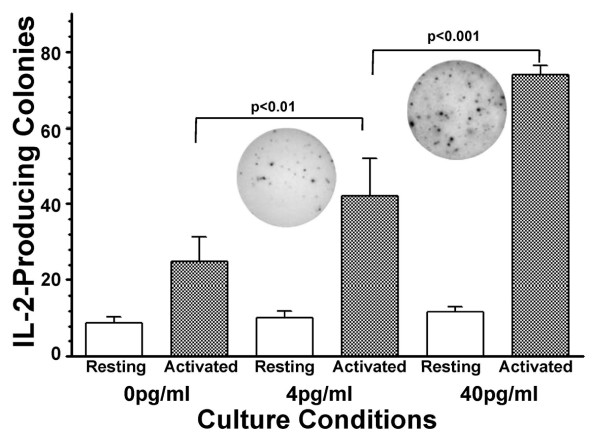
Interleukin-2 (IL-2) production following induction by PMA and ionomycin in physiologic estradiol concentrations. IL-2 production by Jurkat cells exposed to 4 pg/ml estradiol for 48 hours and activated with PMA and ionomycin for 24 hours compared to cells exposed to 40 pg/ml estradiol and activated. The number of IL-2 producing colonies was determined by ELISPOT assay and the values plotted are mean ± standard deviation. The inset images present representative assay plates for activated Jurkat cells in the presence of either 4.0 pg/ml E2 or 40.0 pg/ml E2.